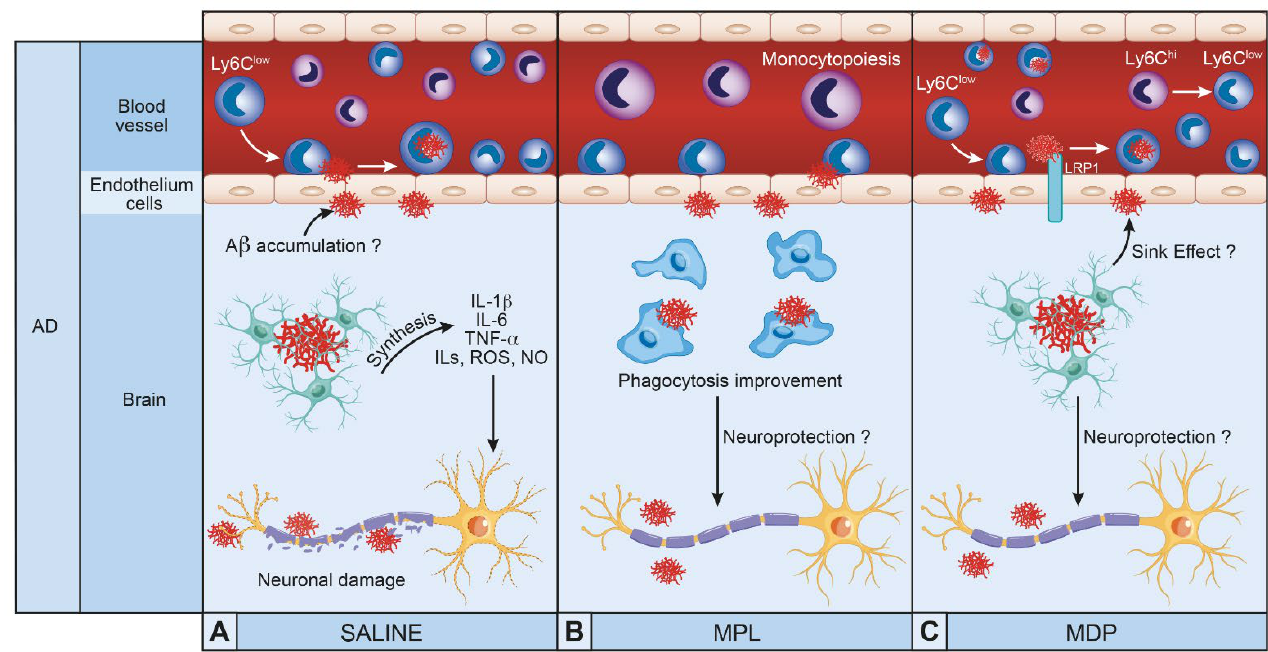
Figure 2. Therapeutic molecules modulating innate immune cells in Alzheimer’s disease (AD): ( A ) Accumulation of amyloid beta (A β ) in the brain over-activates microglia and induces the synthesis of inflammatory cytokines (IL-1 β , IL-6, TNF- α, ROS and NO) implicated in neuroinflammation and neuronal damage. ( B ) Injections of monophosphryl lipid A (MPL) polarize microglia into a neuroprotective aspect and improve microglia phagocytosis toward Aβ. ( C ) Injection of muramyl dipeptide (MDP) convert inflammatory monocytes (Ly6C hi ) into an anti-inflammatory aspect (Ly6C low ) with crawling phenotype. LRP1 transports amyloid through endothelial cells to the luminal side where patrolling monocytes can remove amyloid.